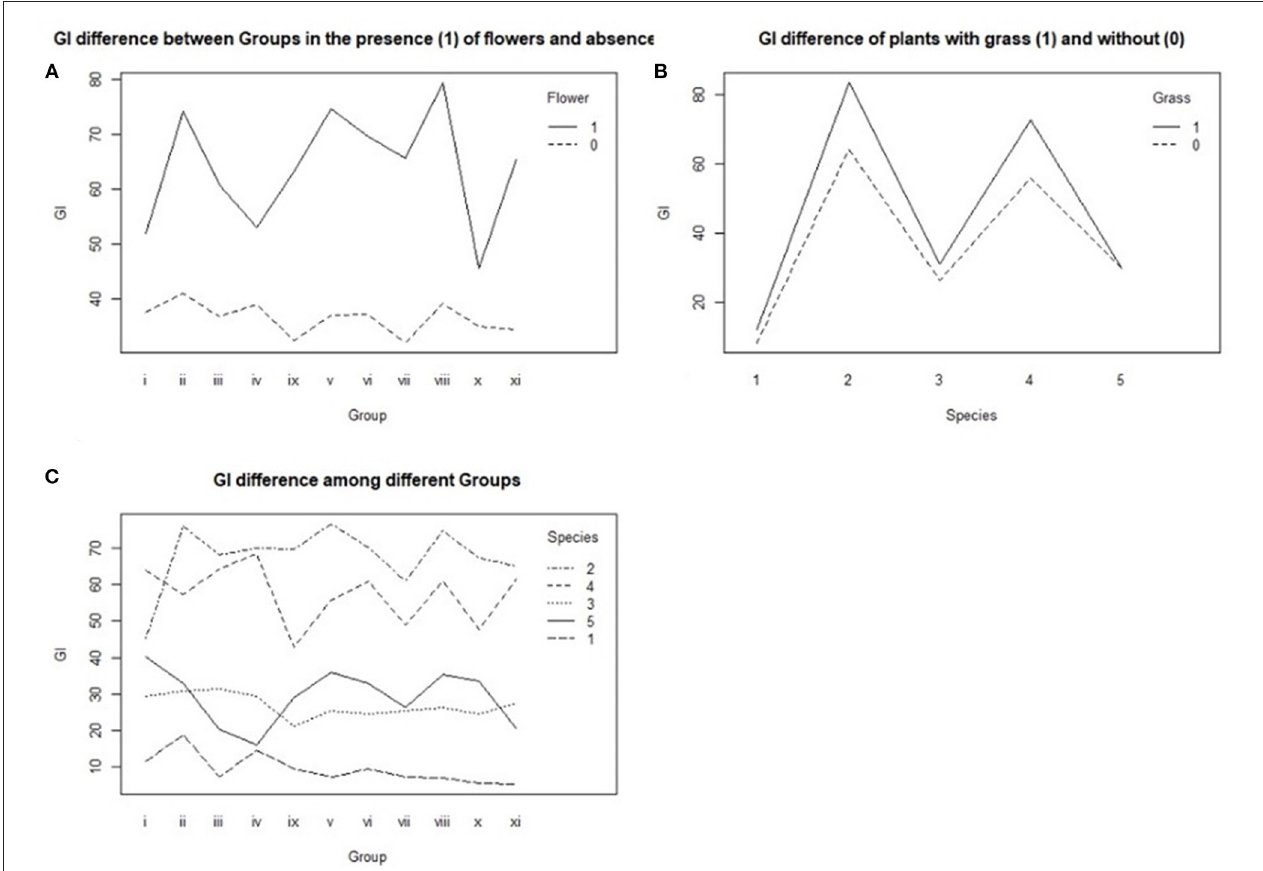
FIGURE 6 | Interaction plots of Species in relation to Flower, Grass and Group. (A) GI difference between Groups (i-xi) in the presence (1) and absence (0) of Flowers, (B) GI difference of plants with Grass (1) and without (0) and (C) GI difference of Species among different Groups (i-xi); where plant species: 1: Sedum sediforme, 2: Medicago arborea, 3: Drosanthemum floribundum, 4: Lavandula angustifolia and 5: Lampranthus spectabilis. Source: